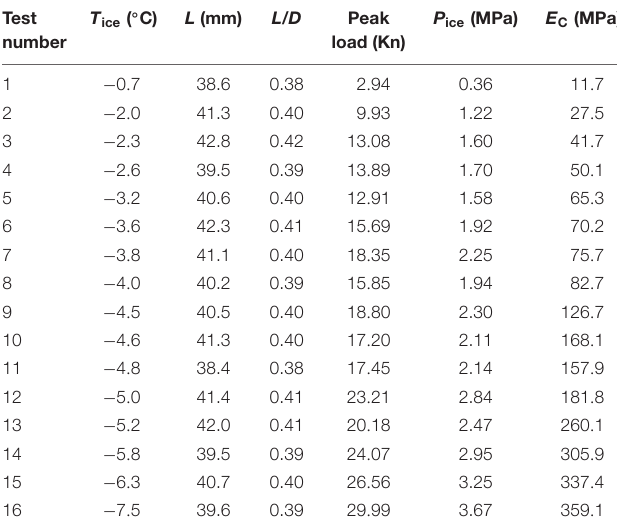
TABLE 1 | Test results of uniaxial unconfined compressive strength of ice.